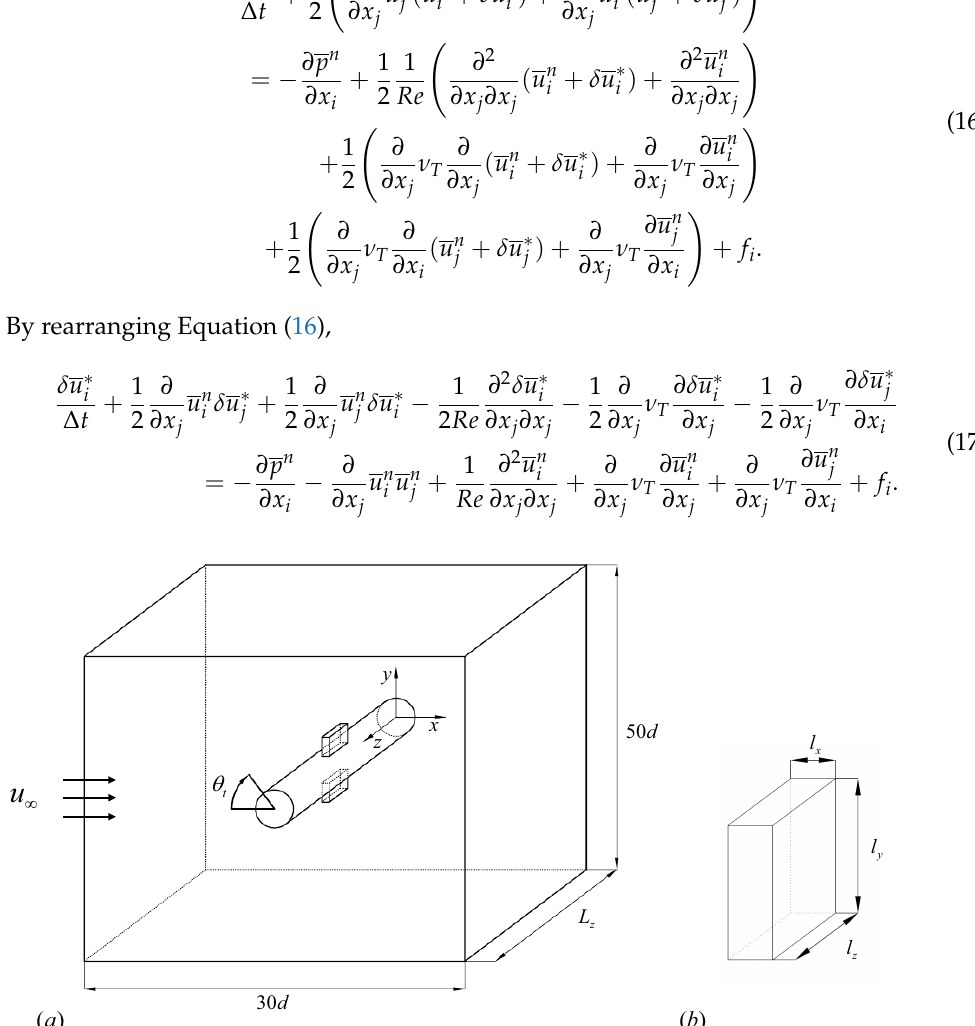
Figure 1. ( a ) Schematic diagram for the coordinate system, computational domain, and geometry of a circular cylinder with tabs; ( b ) geometric parameters of tab thickness ( l x ), height ( l y ), and width ( l z